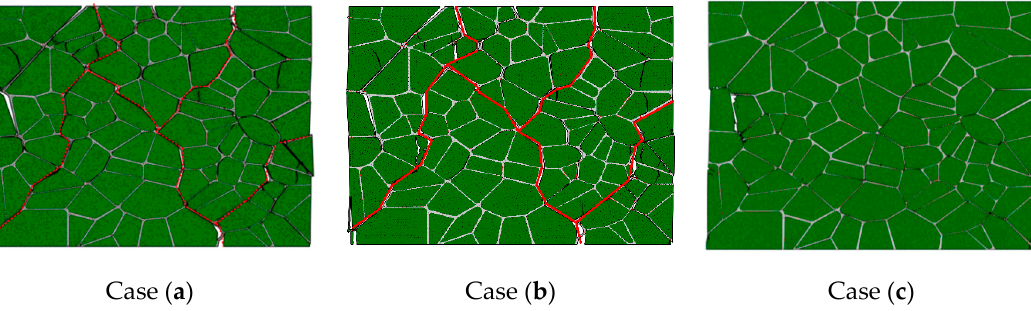
Figure 12. Simulation results for the three boundary conditions: ( a ) traction free vertical edges; ( b ) straight vertical edges; ( c ) periodic vertical edges; under compression loading.